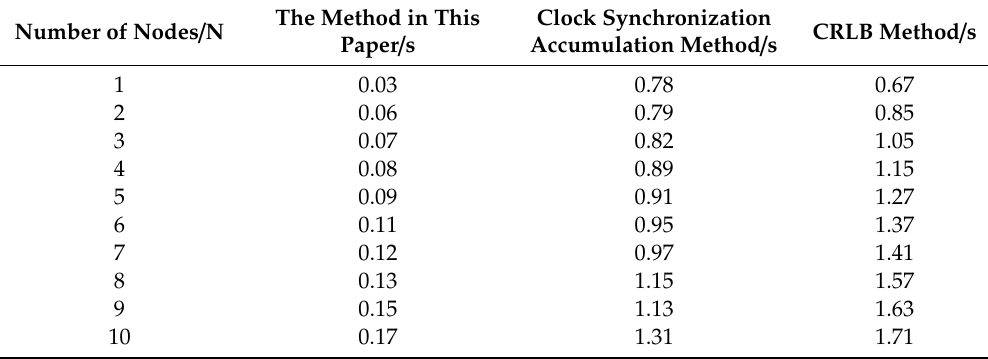
Table 3. CPU runtime comparison.